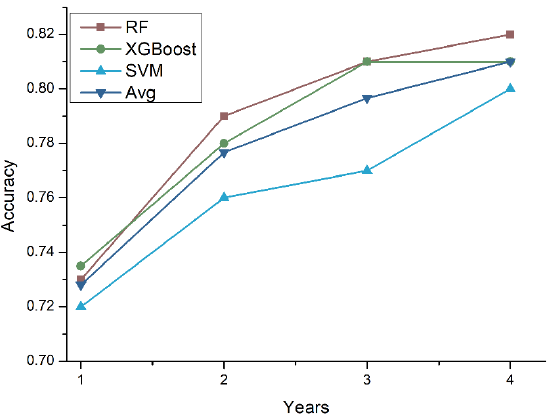
Figure 5. Accuracy comparison using a different number of years for training data (RF = random forest, XGB = XGBoost, SVM = support vector machine, Avg. = average).